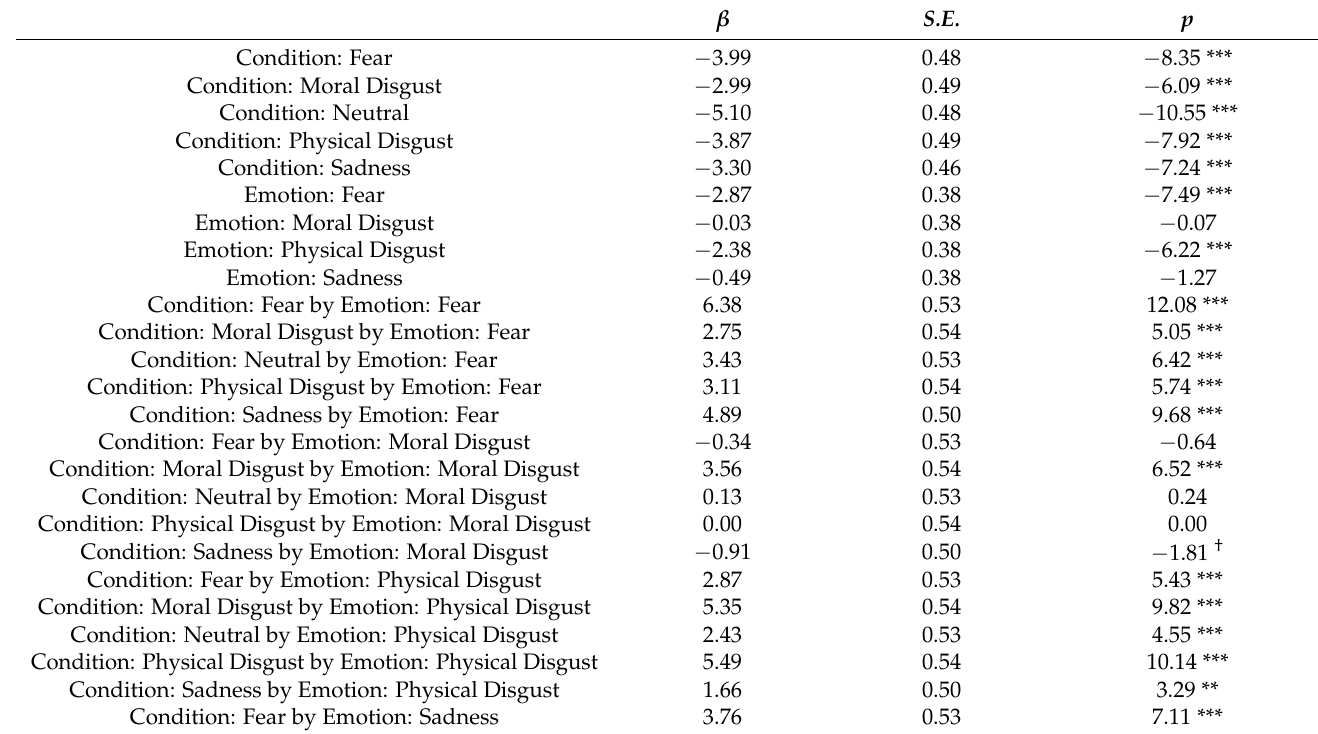
Table 6. Results of the LMM, conducted in Experiment 2. Analyses conducted on the individual ratings using the fixed effects of the condition (Ager, Fear, Moral disgust, Physical Disgust, Neutral), the emotion (Anger, Sadness, Fear, Moral disgust, Physical Disgust), and their interaction